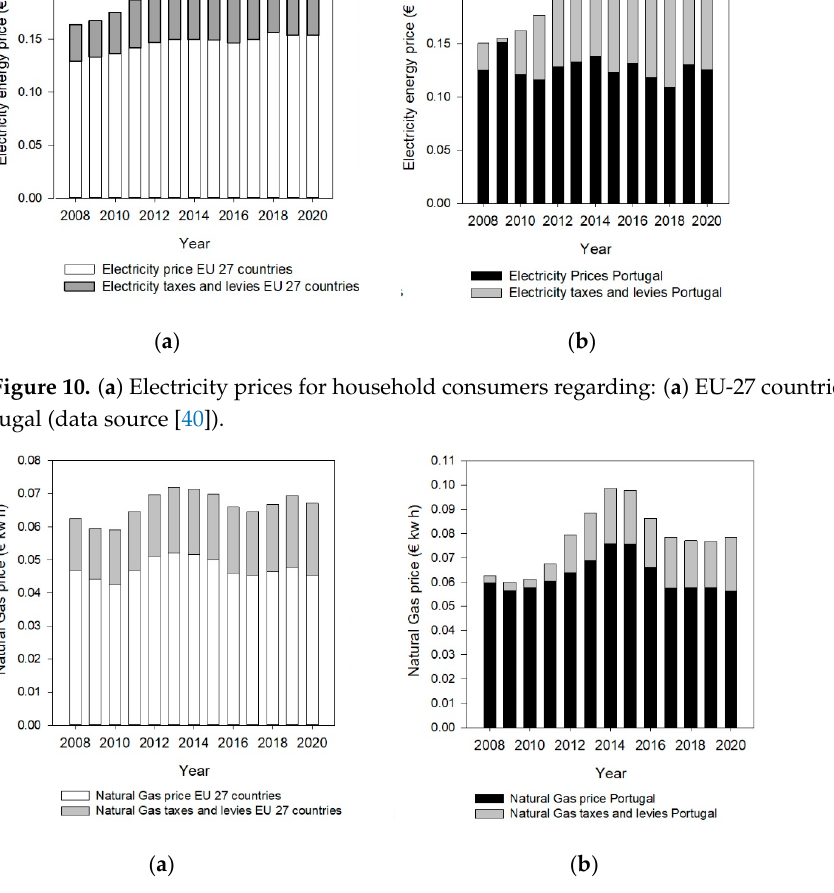
Figure 11. ( a ) Natural Gas prices for household consumers regarding: ( a ) EU-27 countries and ( b ) Portugal (data source [40]).